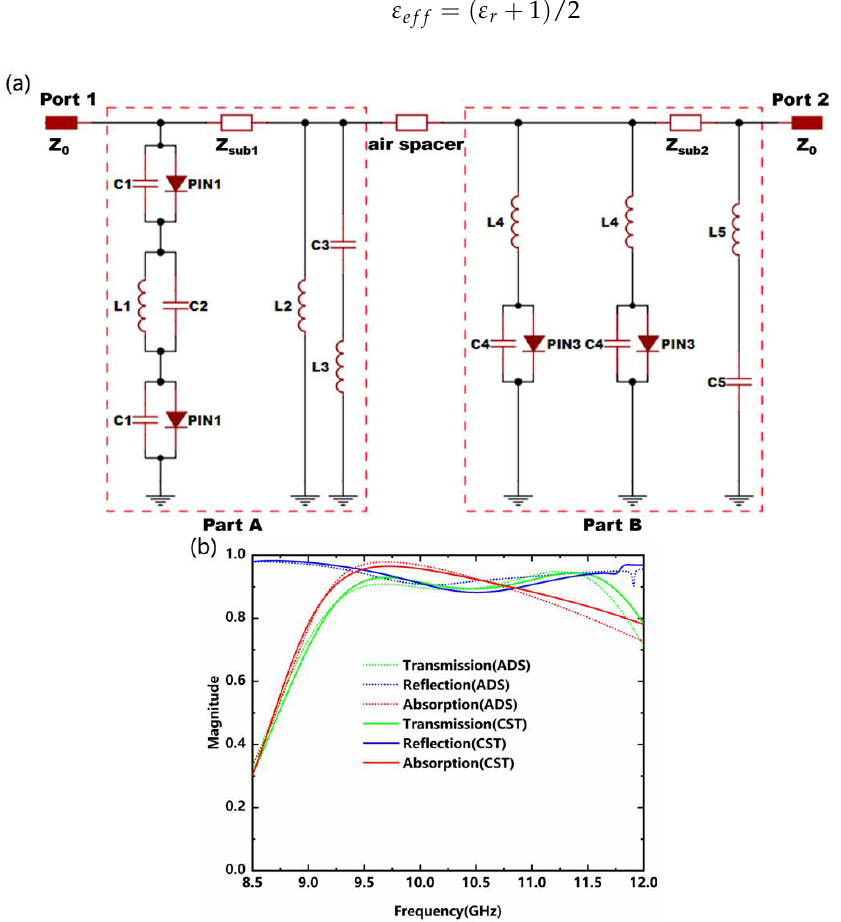
Figure 4. ( a ) Simplified equivalent circuit model of the proposed metadevice; ( b ) Calculation results of transmission, reflection, and absorption in three modes.